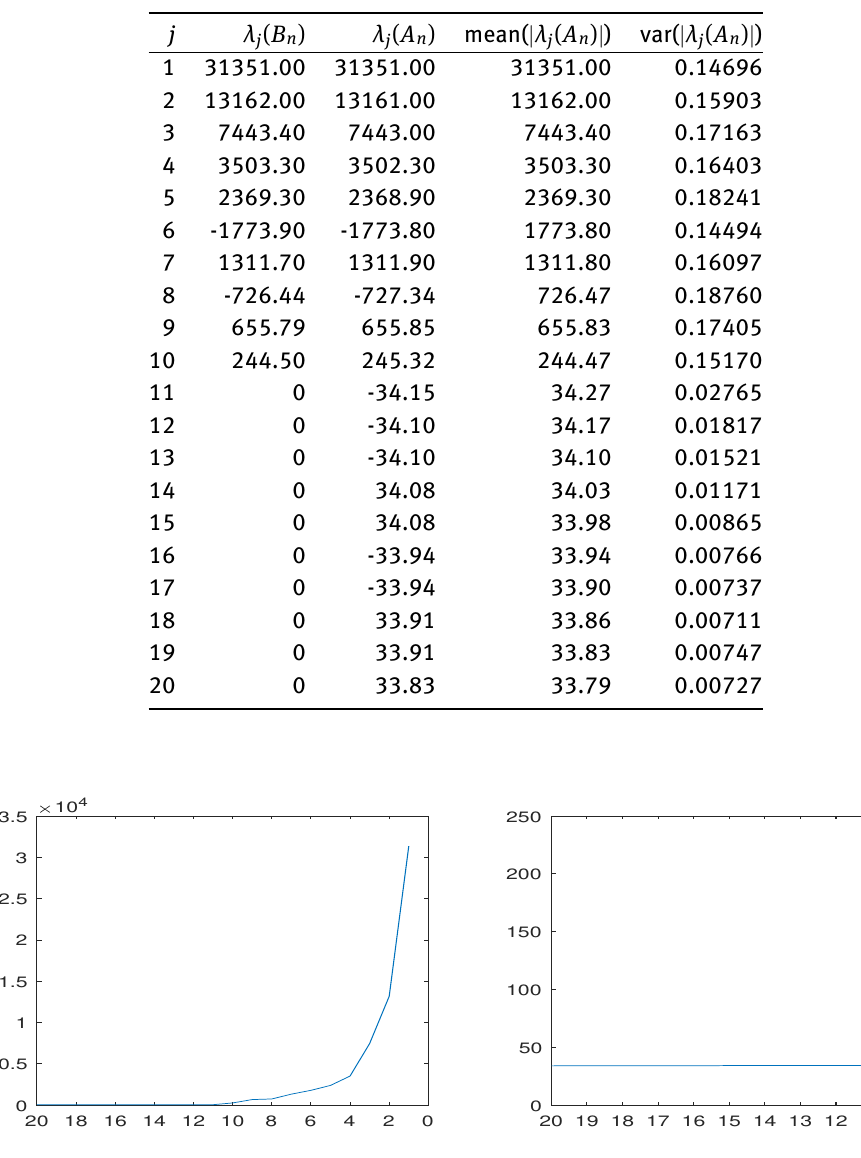
Figure 11: Left side: | λ 20 ( A n ) | < ··· < | λ 1 ( A n ) | ; right side: | λ 20 ( A n ) | < ··· < | λ 10 ( A n ) | in a typical realization in case (c) of Example